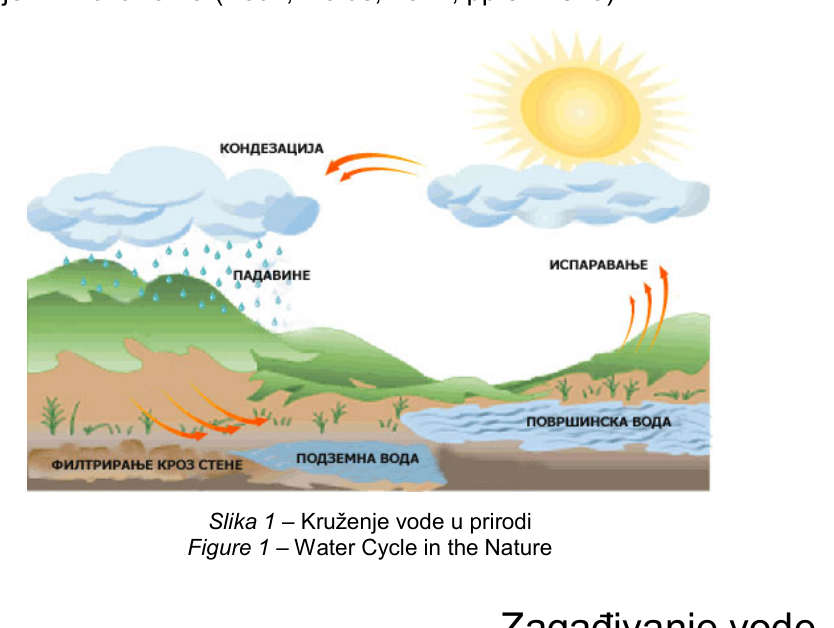
Figure 1 – Water Cycle in the